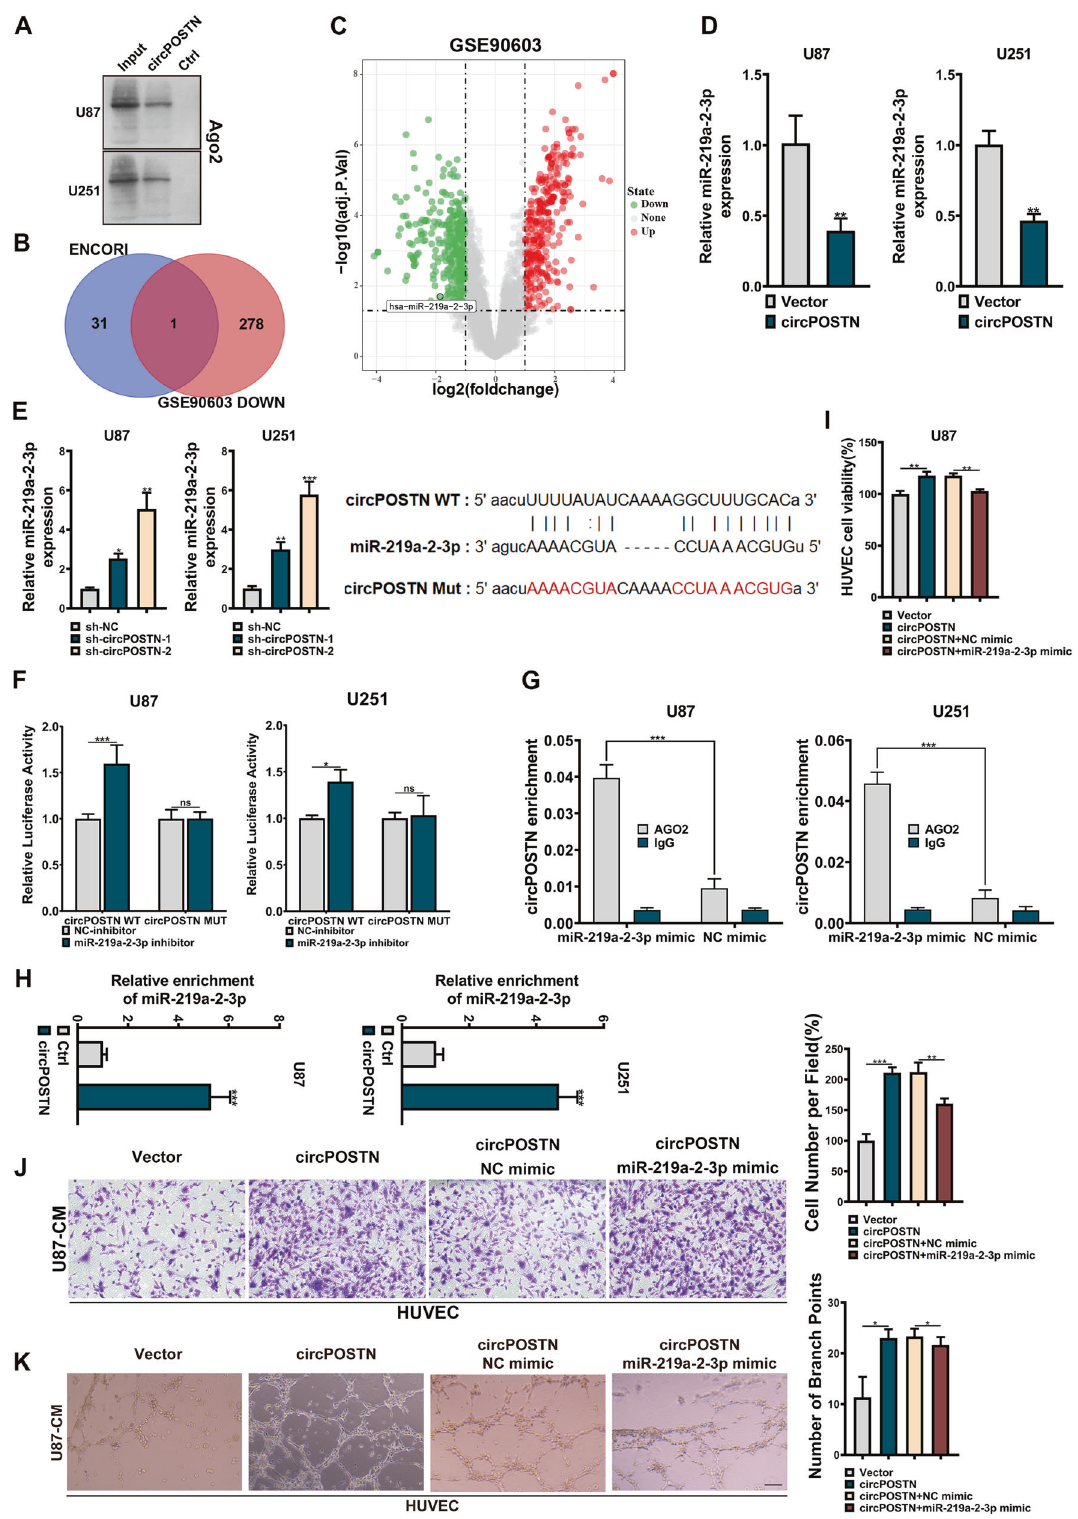
overexpressing cells using ELISA assays (Fig. 6C, P < 0.001). The similar results were observed when perturbating the expression of miR-219a-2-3p (Fig. 6D, P < 0.001) or overexpressing the STC1 (Fig. 6E, P < 0.001). More importantly, we generated four kinds of conditional medium, including the culture medium from negative